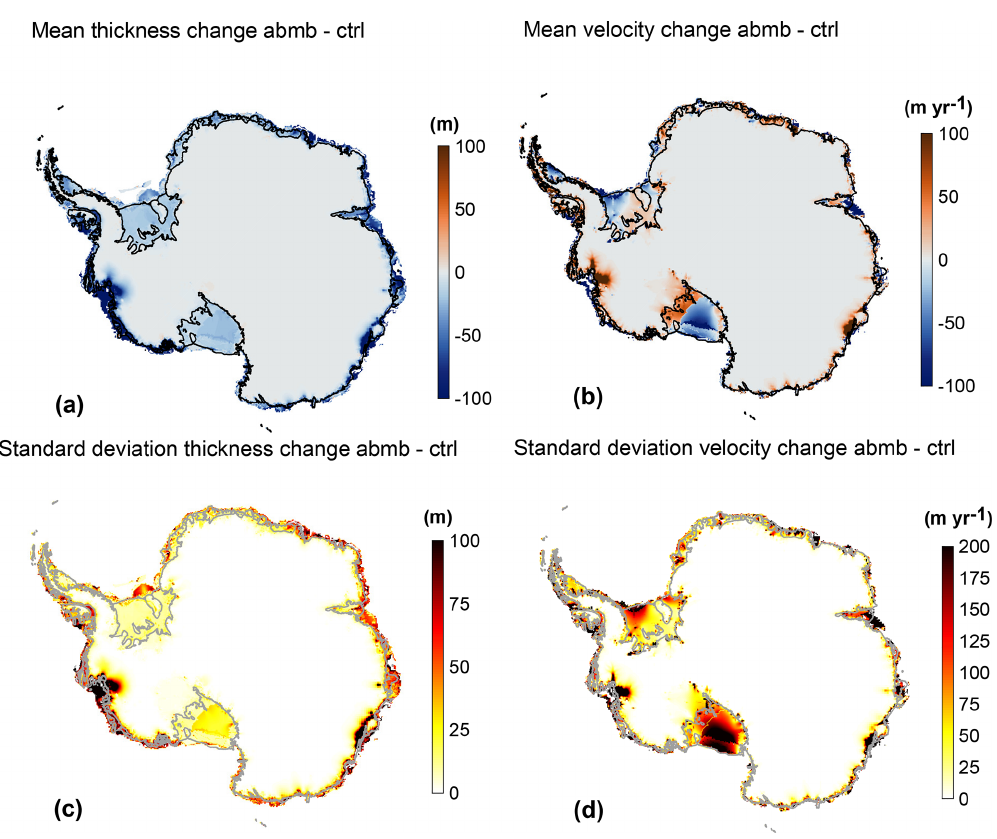
Figure 10. Mean (a, b) and standard deviation (c, d) of the change in ice thickness ( a and c , in m) and depth-averaged horizontal velocity ( b and d , in myr − 1 ) between the end of the abmb experiment and the end of the ctrl experiment. Black (a, b) or grey (c, d) lines show the current observed ice front and grounding line